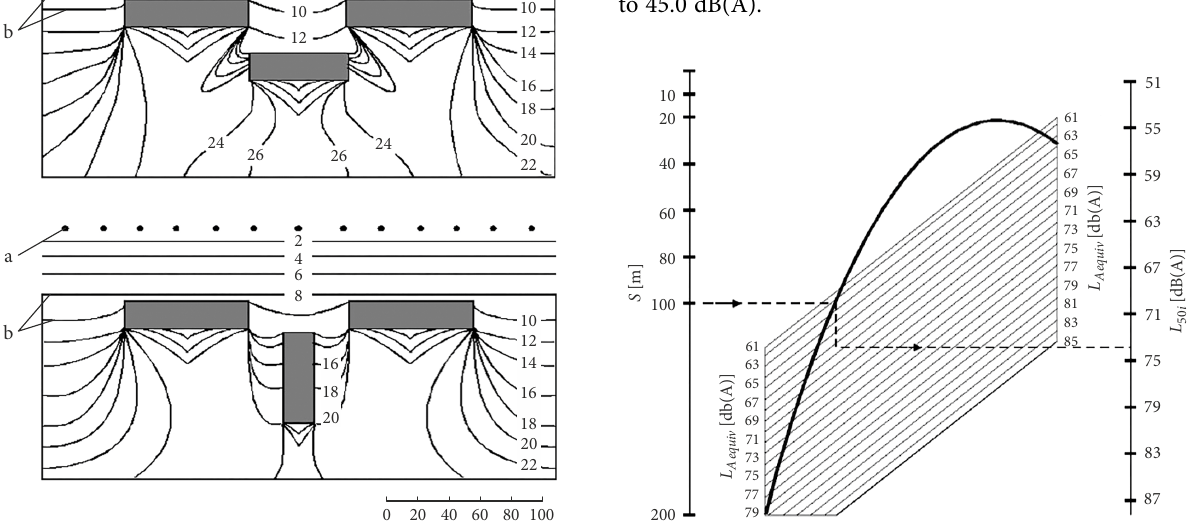
Figure 1. Maps of noise of roadside areas for different options of planning and development [dB(A)]: a – source of noise;